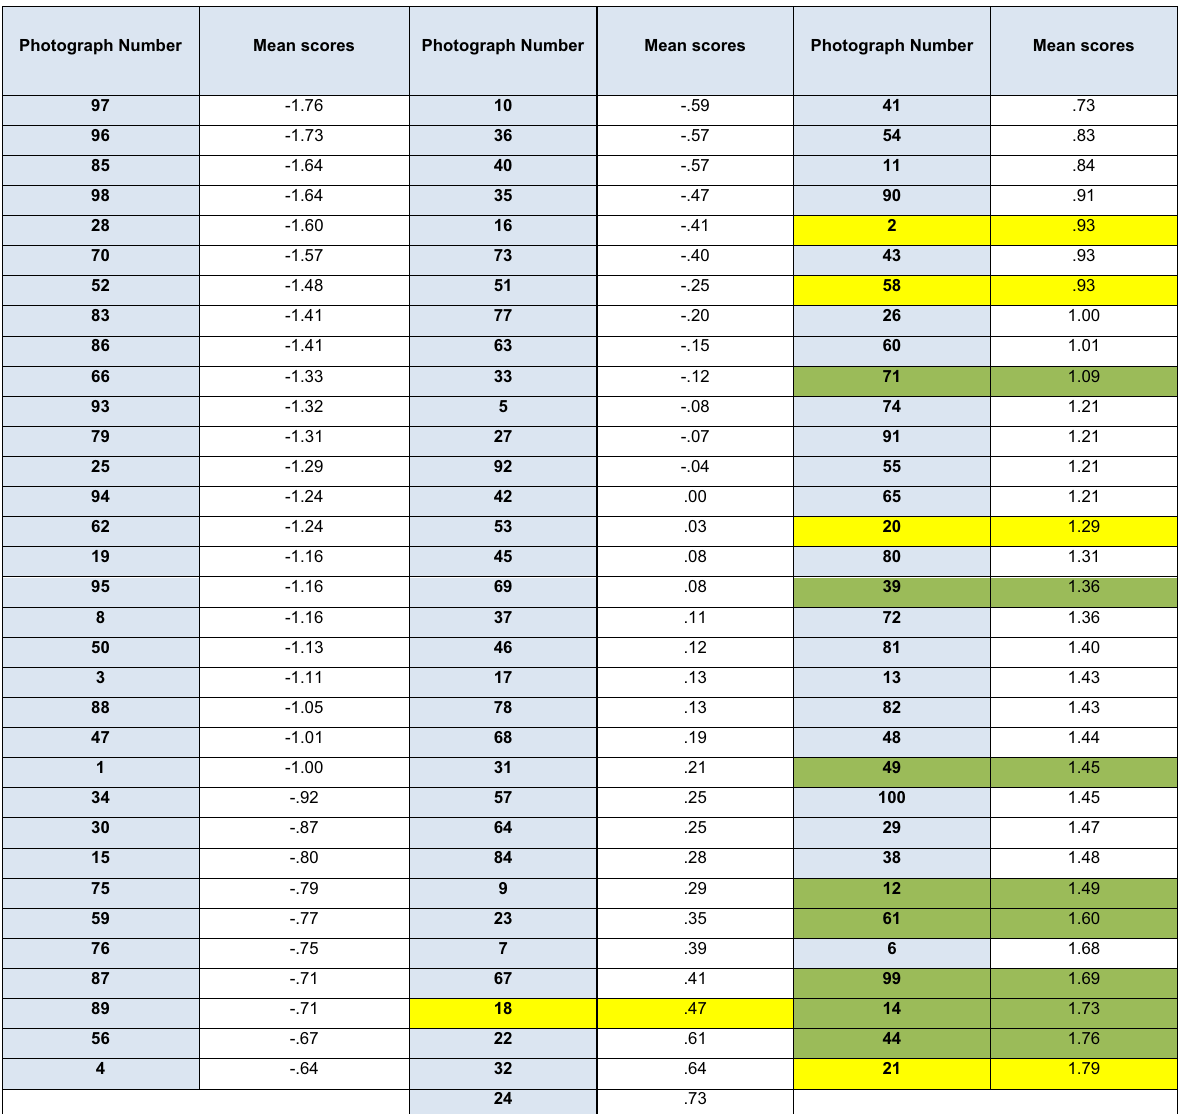
reverse overjet and =